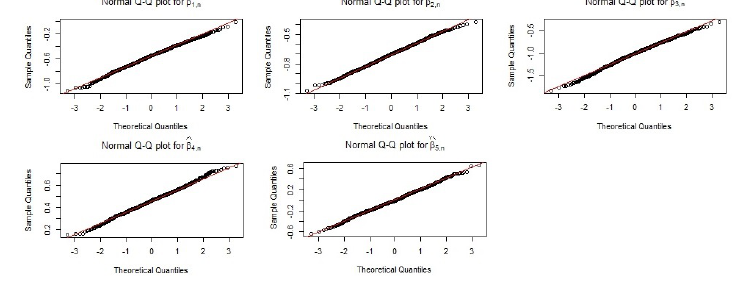
Fig. 2: Normal Q - Q plots for (cid:98) β 1 ,n ,..., (cid:98) β 5 ,n with results are achieved by the maxLik function (n = 500)